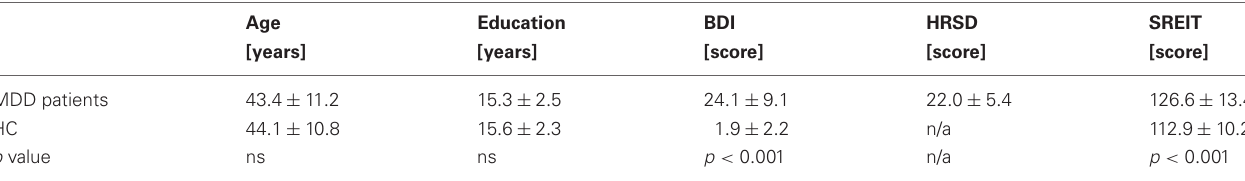
Table 1 | Demographic and clinical characteristics of MDD patients ( n = 23) and healthy controls ( n =